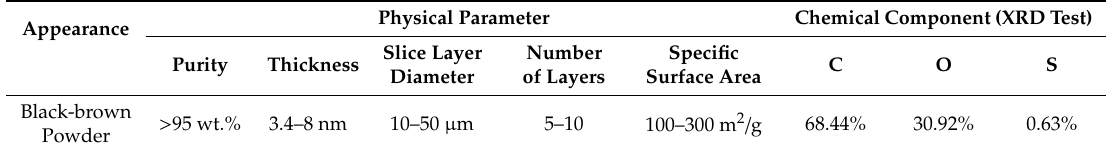
Table 5. Physical and chemical properties of GO nanosheets (kg / m 3